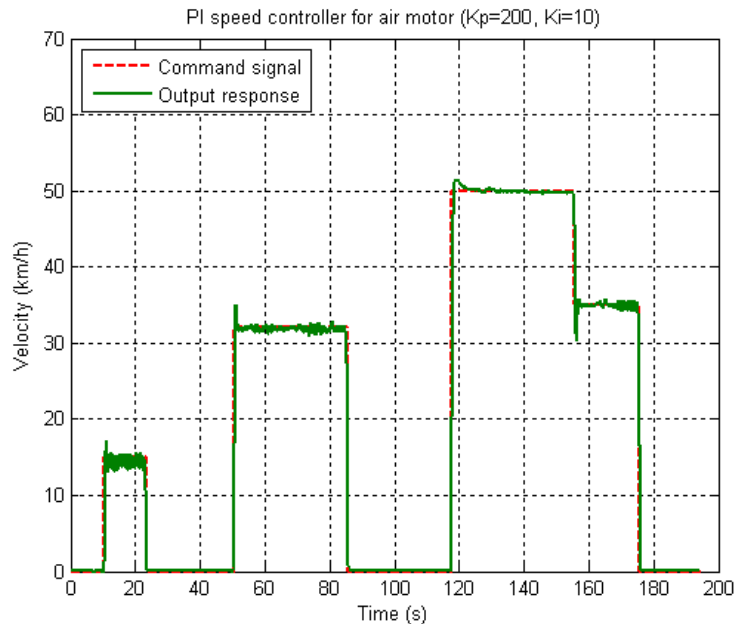
Figure 8. The PI speed control under the air motor